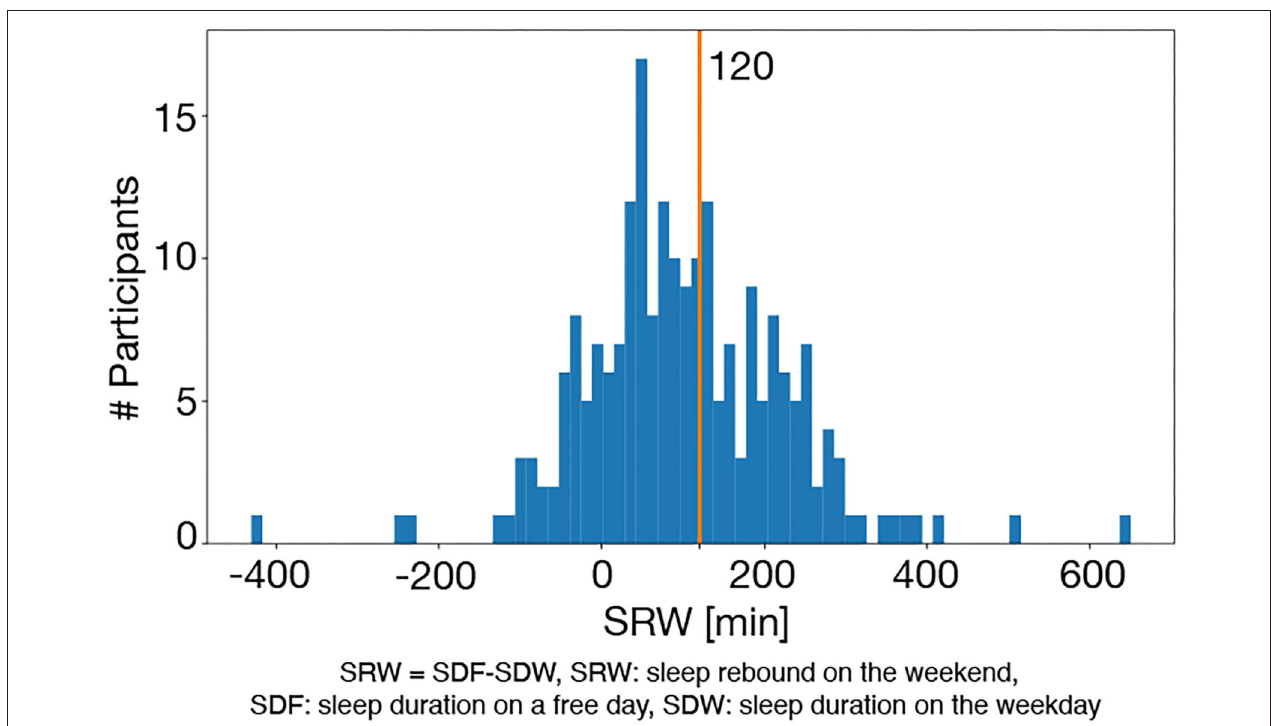
FIGURE 3 | Distribution of SRW: the red vertical line denotes the cut-off value of WSD (120min), and the right and left sides of this line are the WSD and the non-WSD groups.